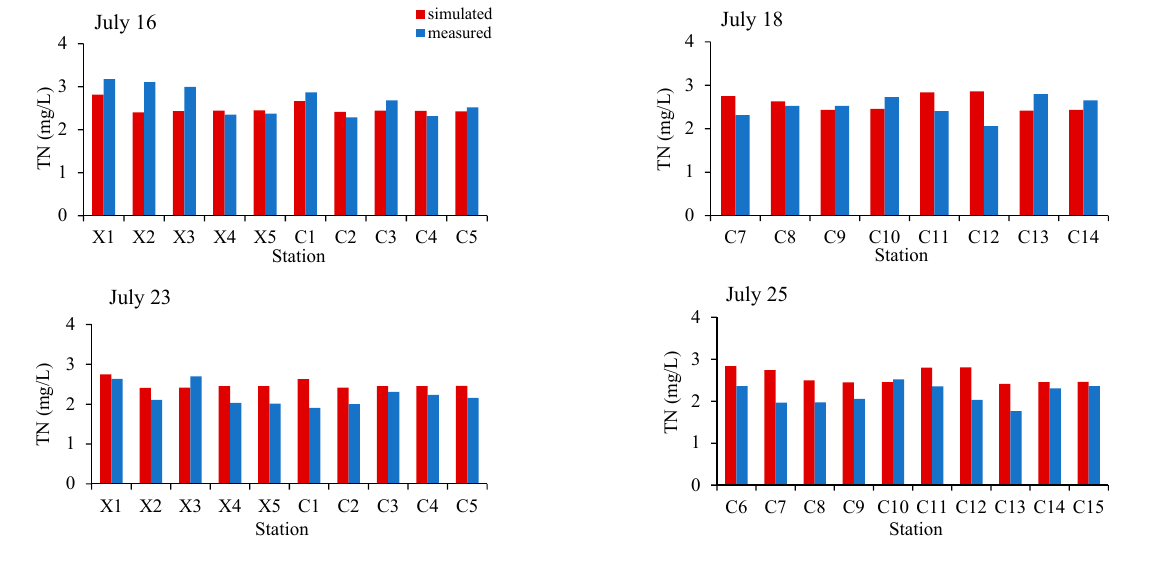
Figure 4. Verification of the TN concentration. Table 2. The average error of TN for July 16–18 2013. Time